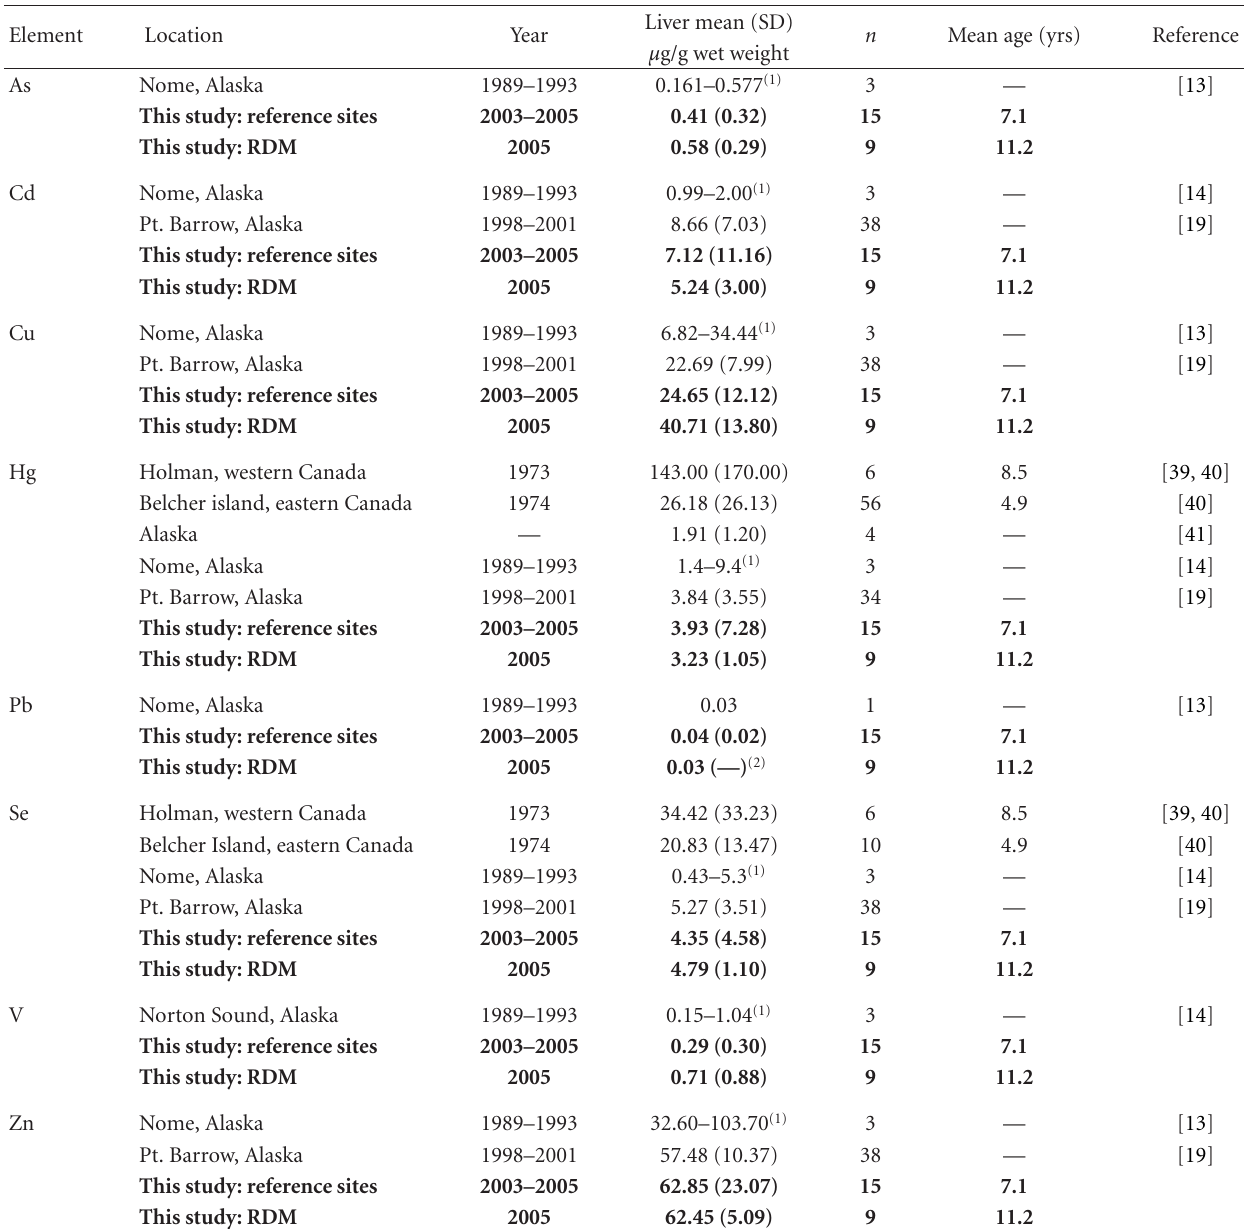
Table 3: Comparisons of element concentrations in liver of bearded seals between this and other studies. Concentration units are μ g/g wet weight and are summarized as the arithmetic mean and standard deviation for comparison with other studies. Mackey et al. [14] and Becker et al. [13] used the same samples from the Alaska Marine Mammal Tissue Archival Project. We present the results of Mackey et al. [14] except when Becker et al. [13] provide data on di ff erent